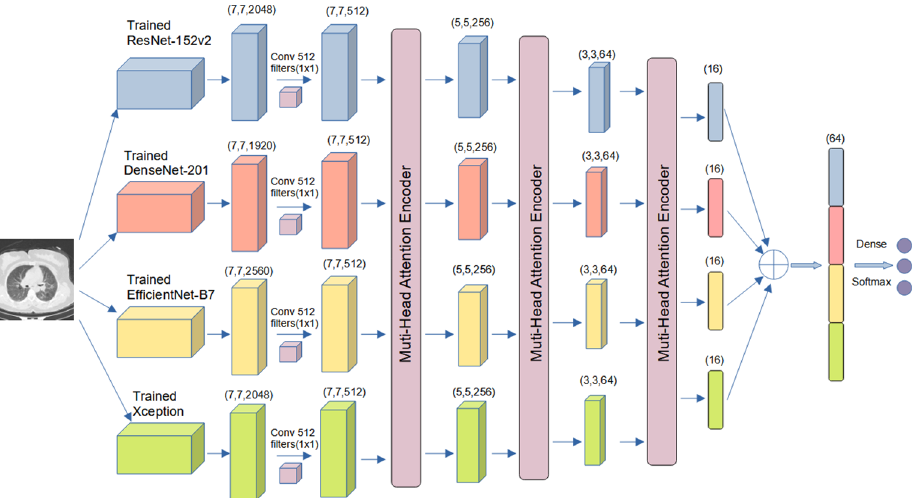
Figure 12. Attentive Ensemble CNN Model.